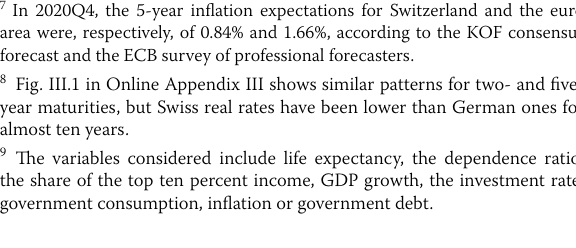
6 E.g., see Rachel and Smith (2015), Hördahl et al. (2016), Demary and Voigtländer (2018), Rachel and Summers (2019). Lunsford and West (2019) focus on the US real rate.